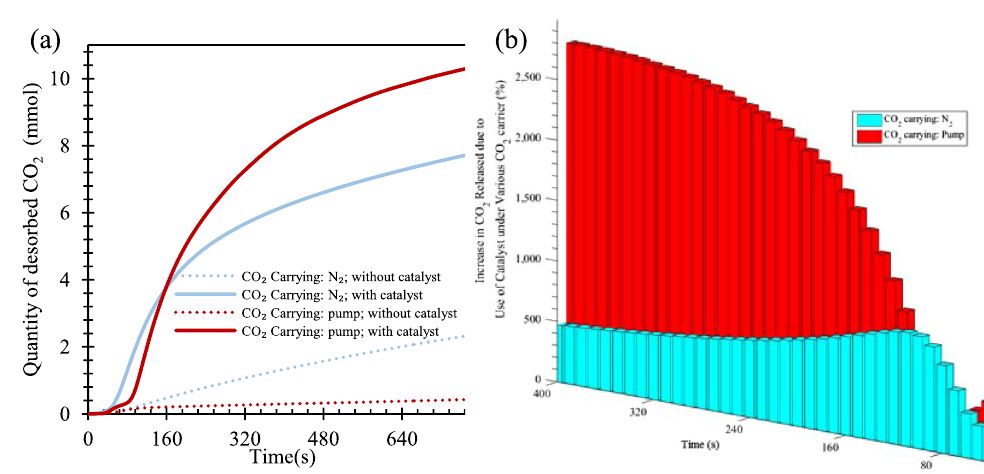
Figure 9. ( a ) Effect of different CO 2 carrying out methods on CO 2 release [initial NaHCO 3 concentration: 0.238 mol/L; Ti/Na molar ratio: 0.78; stirring rate: 600 rpm; reaction temperature: 65 °C, N 2 flow rate: 200 mL/ min; power of pump: 12 W]. ( b ) Ratio of CO 2 released by using N 2 gas and the pump with and without uses of catalyst for each 10